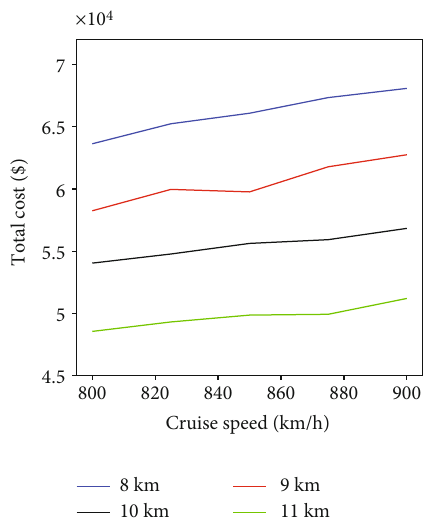
Figure 6: Generator and battery power generation results under standard cruise altitude speed, mass, and gravity center position.